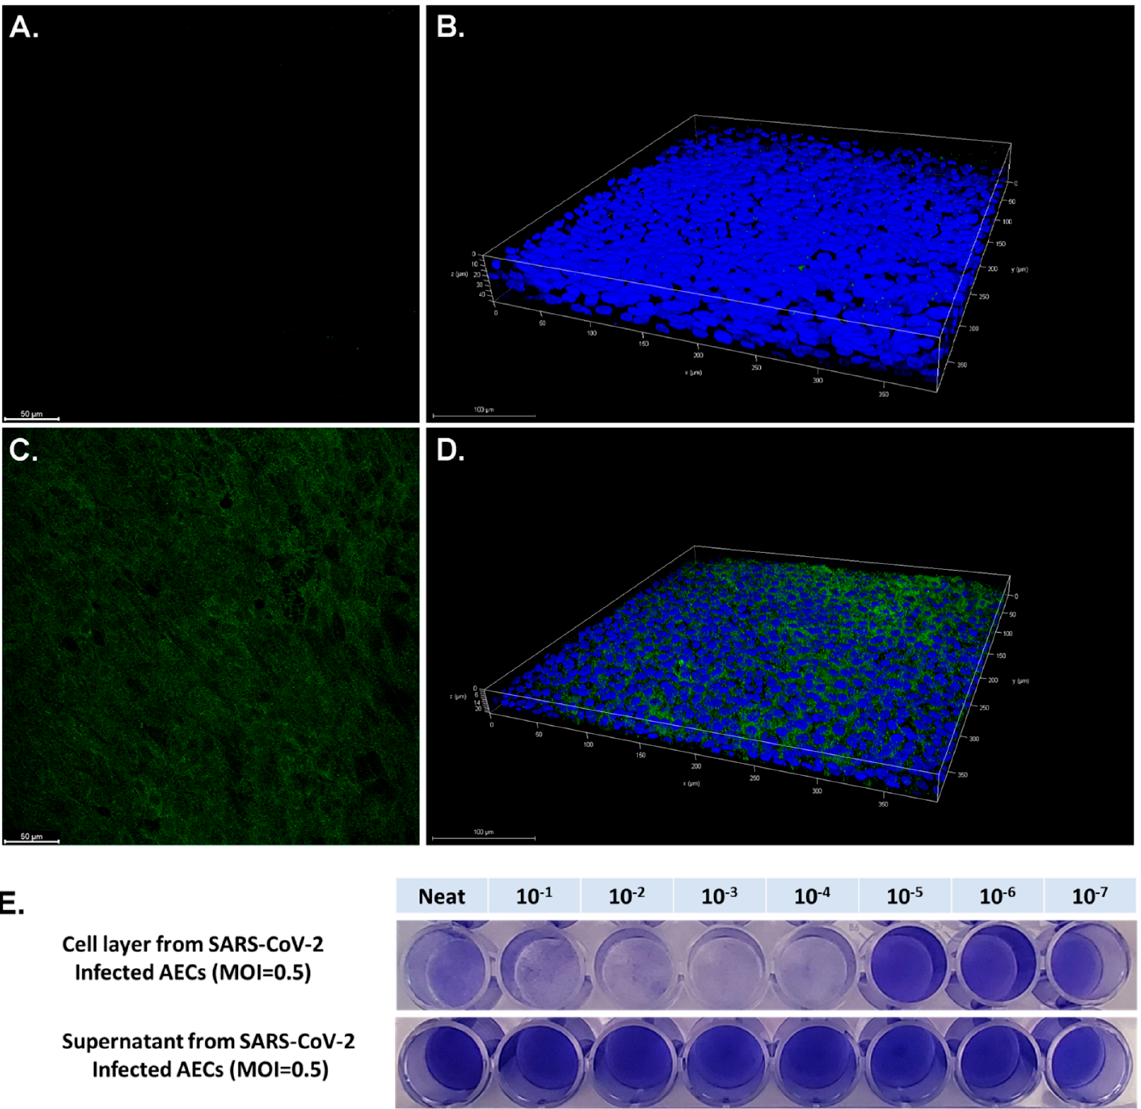
Figure 2. Confocal images of uninfected differentiated airway epithelial cells (AECs) and AECs following infection with SARS-CoV-2 at a MOI of 0.5 for 96 h labeled for spike protein (green) and 4 ′ ,6-diamidino-2-phenylindole (DAPI) (blue). Panel ( A ) presents an image obtained from the apical portion of the differentiated uninfected AEC layer. Panel ( B ) presents a 3-dimensional reconstruction of the uninfected AEC layer. Panel ( C ) presents an image obtained from the apical portion of a SARS-CoV-2-infected AEC layer. Panel ( D ) presents a 3-dimensional reconstruction of the SARS-CoV-2-infected AEC layer. Panel ( E ) presents crystal violet stained Vero cells exposed to cell layer harvested from positive control SARS-CoV-2-infected AECs (Neat concentration represents all cell layer material scrapped from an AEC transwell suspended in 100 µ L of phosphate buffered saline) and supernatant from SARS-CoV-2 infected AECs. Positive control SARS-CoV-2 infected AEC experiments were completed using 3 separate human primary AEC lines (3 human donors) with consistent results from all three AEC lines.